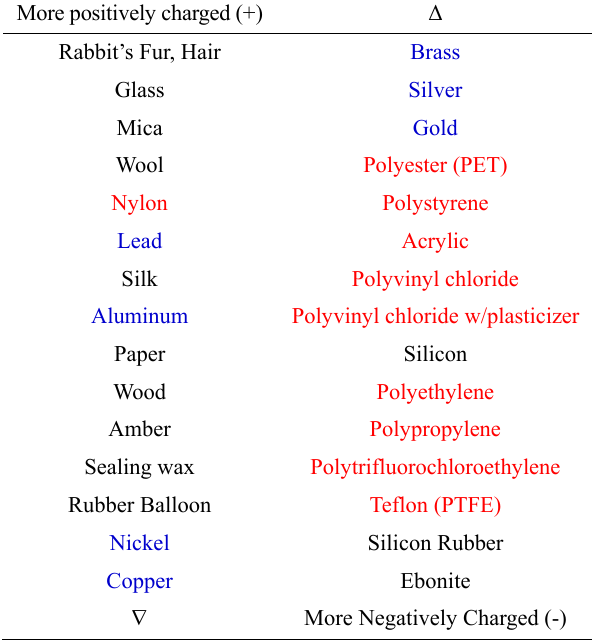
Table 3 Triboelectric series short